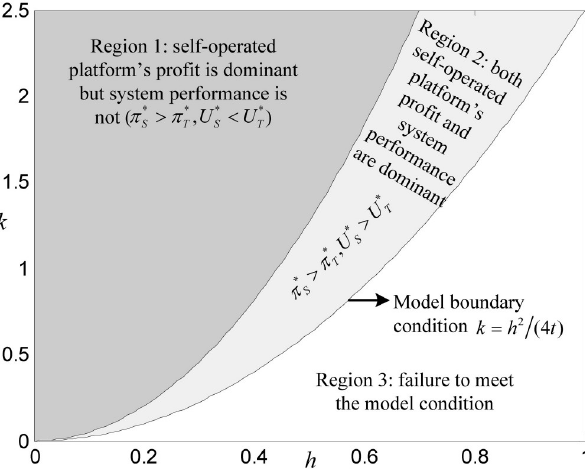
Fig 6. Comparison of profits and systems performance between both platforms.